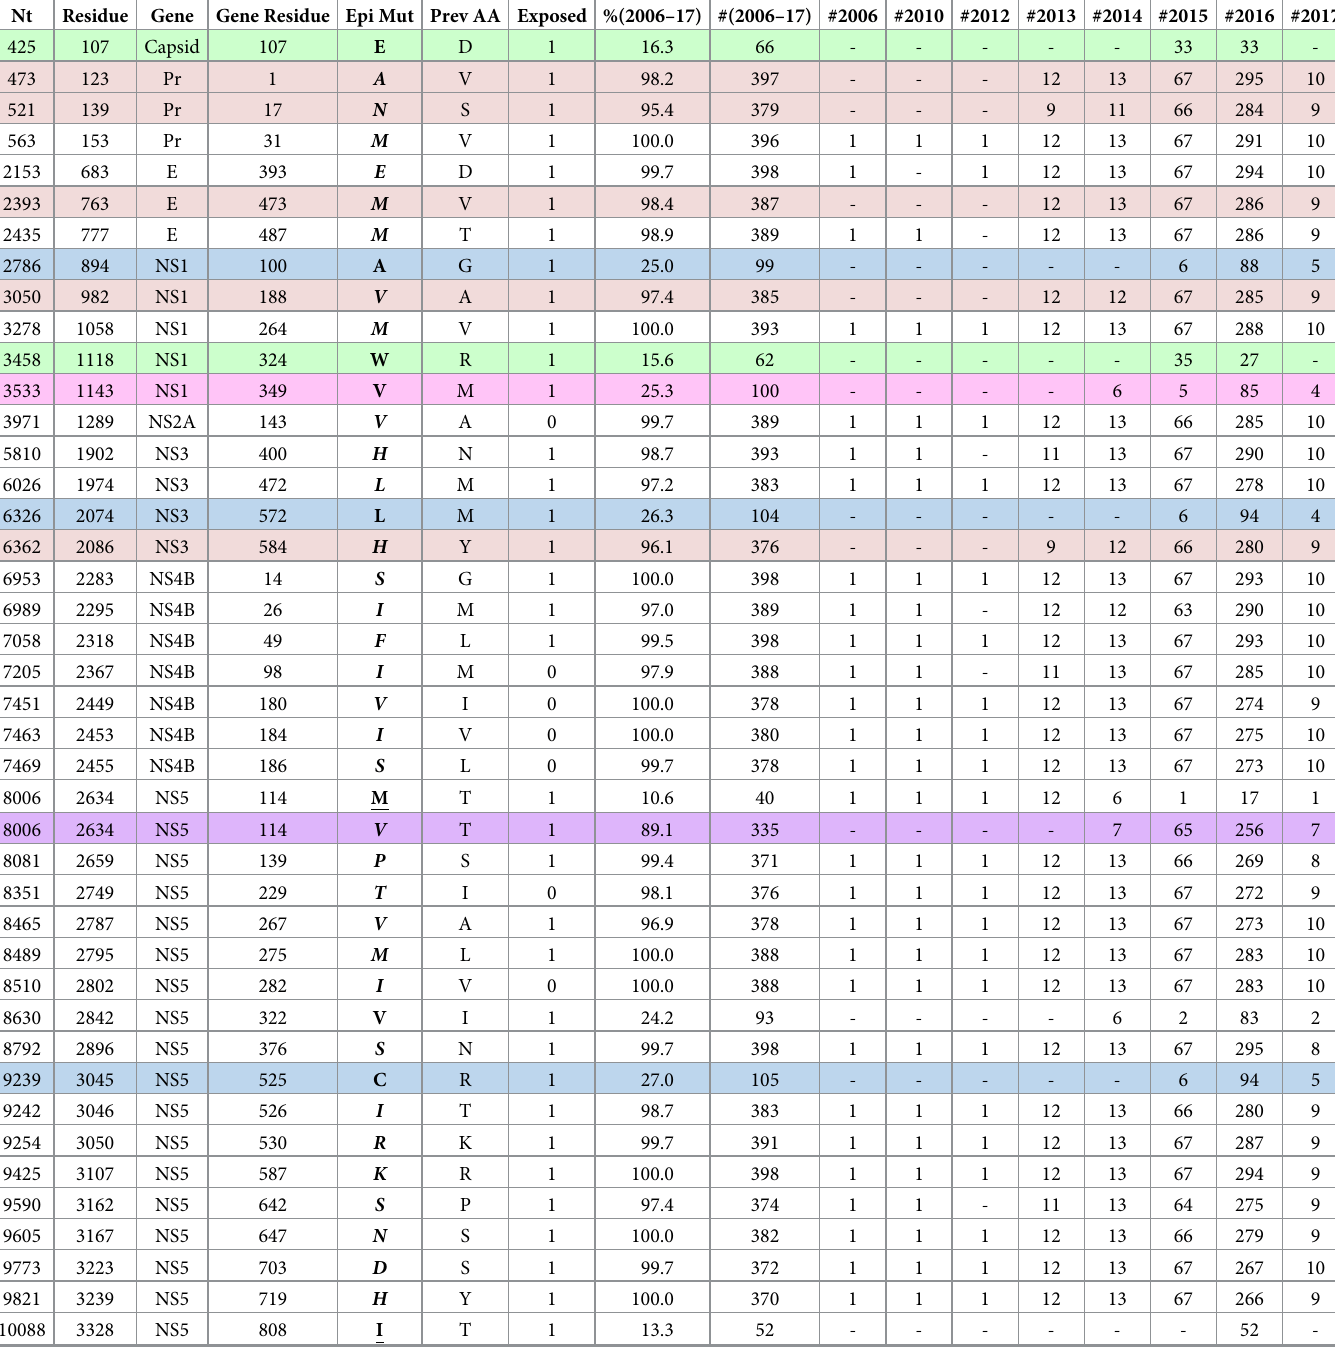
Table 6. Structural analysis of mutations associated with epidemic trajectory and microcephaly. The percentage of mutations occurring in greater than 10% of ZIKV genomes (Asian Lineage) between 2010–2017, with at least 25 cases occurring in 2016, is shown in middle column “%(2006–17)”. Mutations that are predicted by protein structural models to occur in exposed regions of the protein are marked as a “1” in the “Exposed” column, and mutations predicted to occur in buried regions are marked as “0”. Cells with the 5 mutations that occurred in 2013 (as shown in Fig 1) are red, and cells representing the 2014 NS5 Thr114Val mutation are light purple. Cells